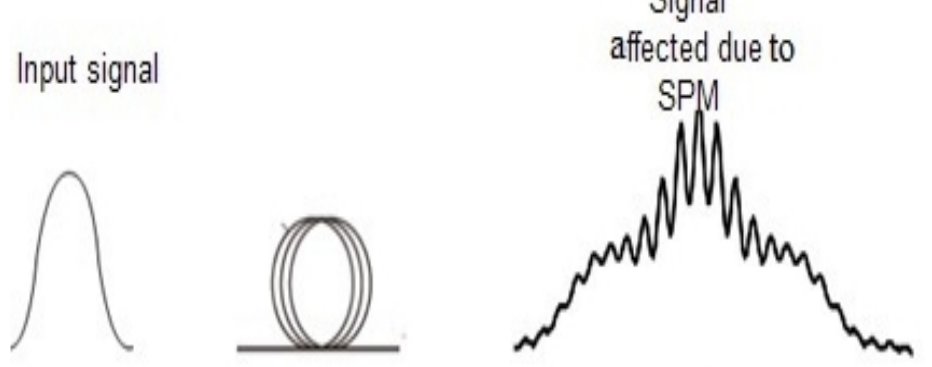
Figure 5. Pulse broadening due to self phase modulation (SPM)